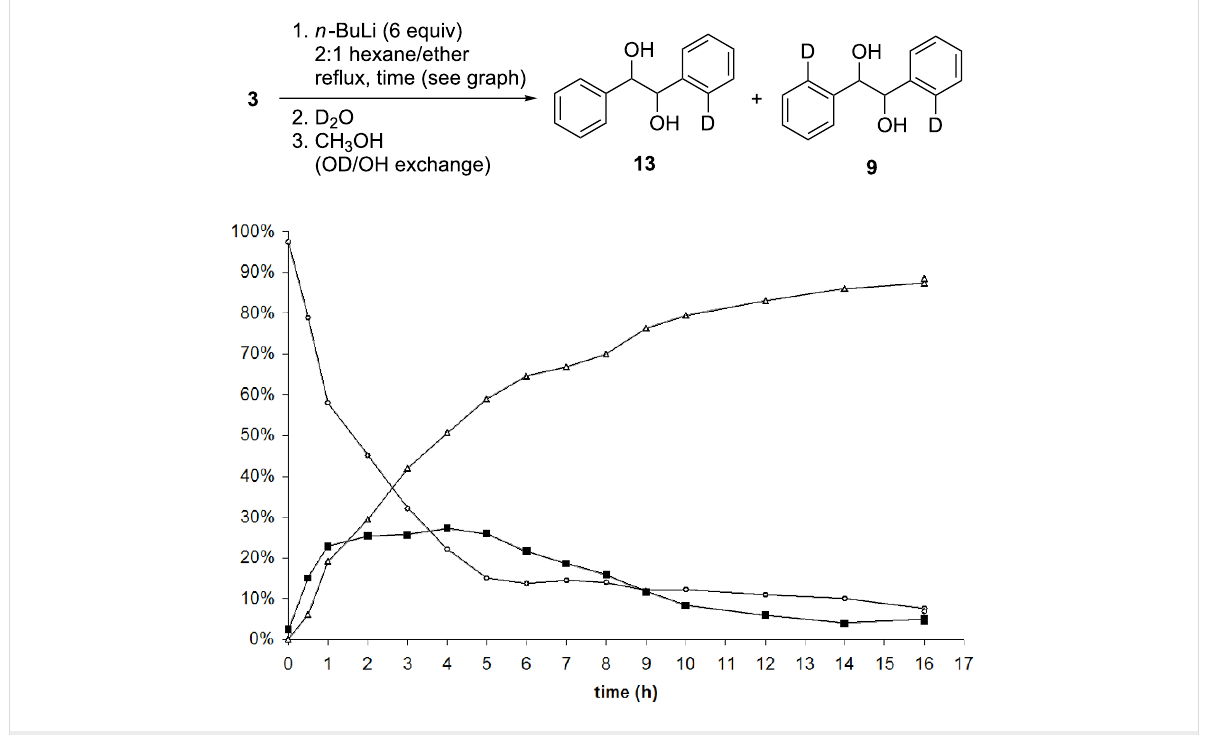
Figure 2: Percentage of ( R , R )-hydrobenzoin ( 3 ) ( ○ ), monodeuterohydrobenzoin ( 13 ) ( ■ ), and dideuterohydrobenzoin ( 9 ) ( Δ ) as determined by mass spectrometry (ESI) [23].